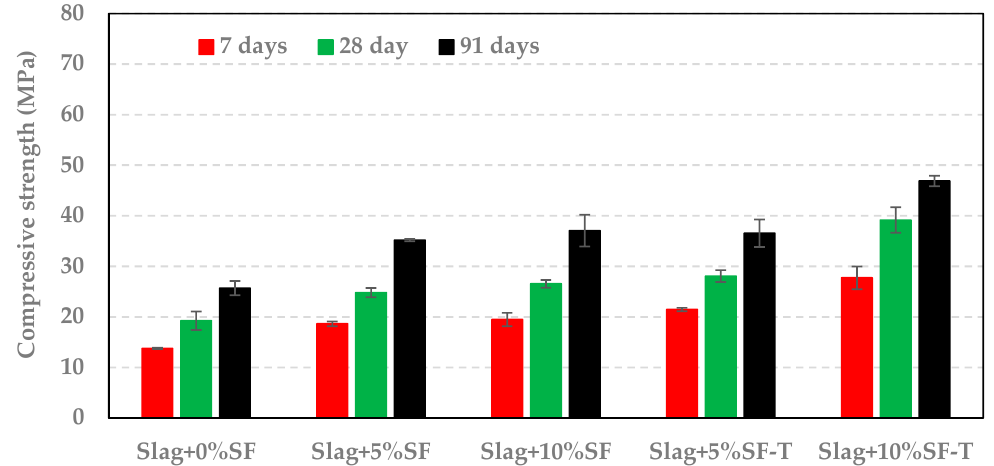
Figure 9. Compressive strength of samples containing silica fume.